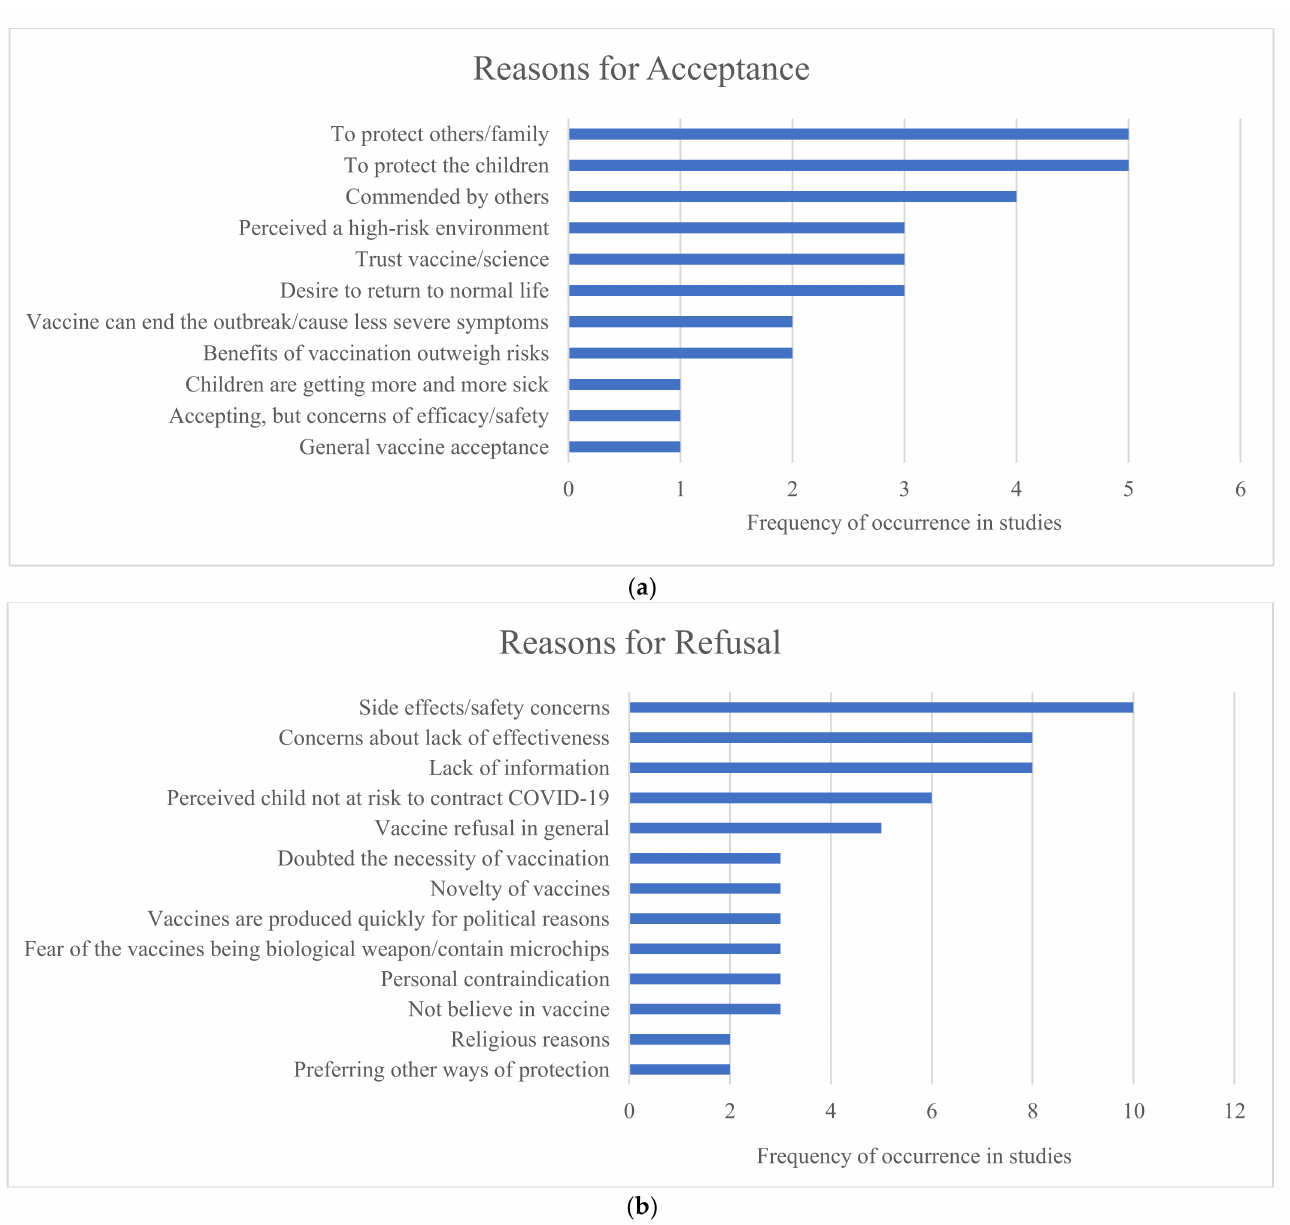
Figure 2. Frequency of reasons of parents’ intention to vaccinate children against COVID-19: ( a ) frequency of reasons for vaccine acceptance; and ( b ) frequency of reasons for vaccine